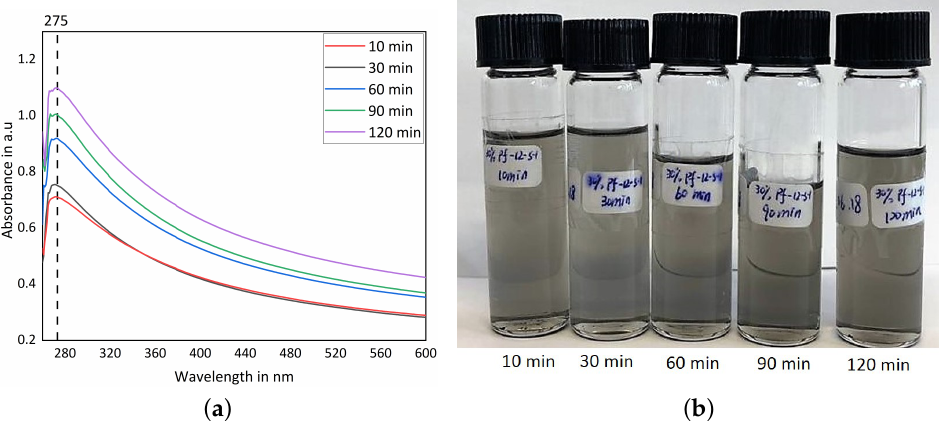
Figure 3. ( a ) UV-VIS spectrum of different fMWCNT dispersions with different duration of ultrasonic treatments; ( b ) Diluted fMWCNT/2-propanol dispersions at different sonication time.